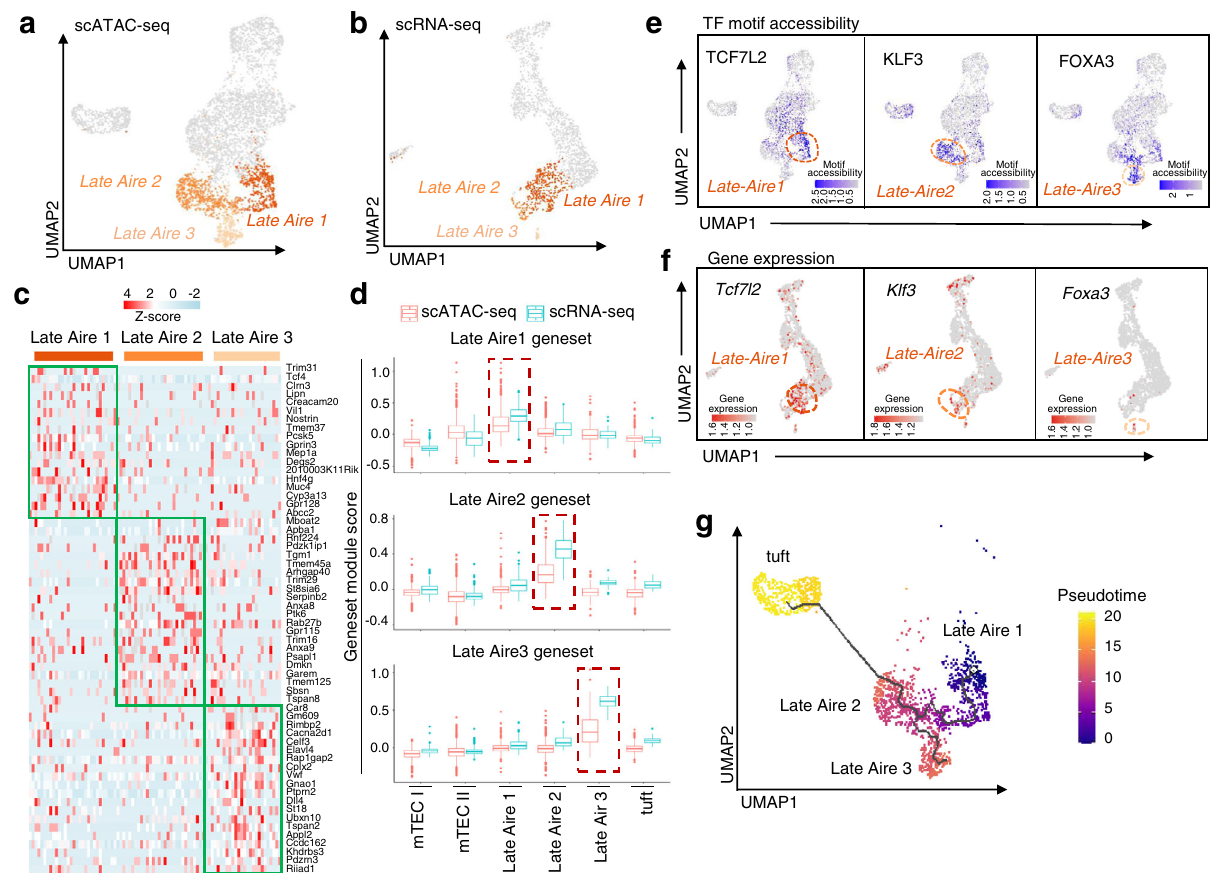
Fig. 2 Chromatin accessibility, gene expression, and differentiation trajectory of three newly identi fi ed mTEC III subsets. UMAP visualization of scATAC-seq pro fi les ( a ) and scRNA-seq pro fi les ( b ). Late Aire 1, Late Aire 2, and Late Aire 3 cells labeled with different colors are de fi ned by the different chromatin accessibility in scATAC-seq and scRNA-seq pro fi les. c Heatmap of the gene expression pro fi le of late Aire 1 – 3 populations in scATAC-seq was generated by the top 20 marker genes from the gene activity matrix. The color scale indicates the level of gene activity. d Marker genes of each Late Aire population calculated by scATAC-seq were added to both scRNA-seq and scATAC-seq. The gene set module scores of Late Aire 1-3 in scRNA-seq (blue) and scATAC-seq (red) were compared in boxplots. e UMAP visualization of TF motif accessibility for the indicated TFs in Late Aire 1, Late Aire 2, and Late Aire 3 cells. The blue scale in the UMAP plot indicates the level of TF motif accessibility in scATAC-seq analyzed by chromVAR. f UMAP visualization of scRNA-seq colored based on the expression of the indicated TFs in Late Aire 1, Late Aire 2, and Late Aire 3 cells. The red scale in UMAP plot indicate the level of gene expression in scRNA-seq. g UMAP visualization of scATAC-seq subsets of Late Aire 1, Late Aire 2, Late Aire 3, and thymic tuft cells. Colored based on the pseudotime, with blue corresponding to early cells and yellow corresponding to thymic tuft